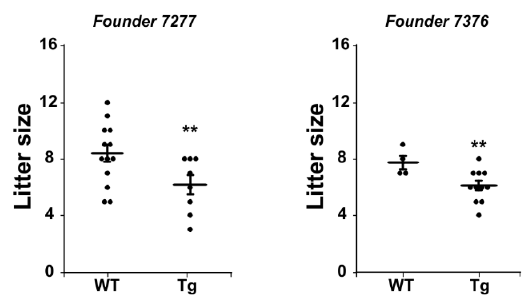
Figure 3. CMV-hDENND1A.V2 transgenic mice have morphologically normal ovaries. ( A ) Representative histological images from ovaries collected from wild-type and CMV-hDENND1A.V2 transgenic mice. ( B ) Measurements of the ovary weight from wild-type and transgenic mice for two of the founder lines. No significant differences were found in the histologic appearance and weights of PMSG/hCG-stimulated Tg and WT ovaries. For the 7277 founder, p = 0.73; for the 7376 founder; p = 0.61. WT, wild-type; Tg, transgenic.